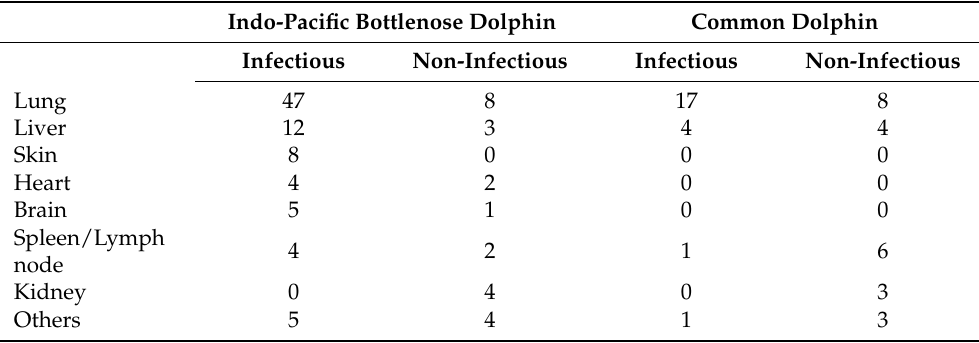
Table A5. Organs showing inflammation, classified by dolphin species, during the St Vincent Gulf Bioregion, South Australia, study in 2009–2020.